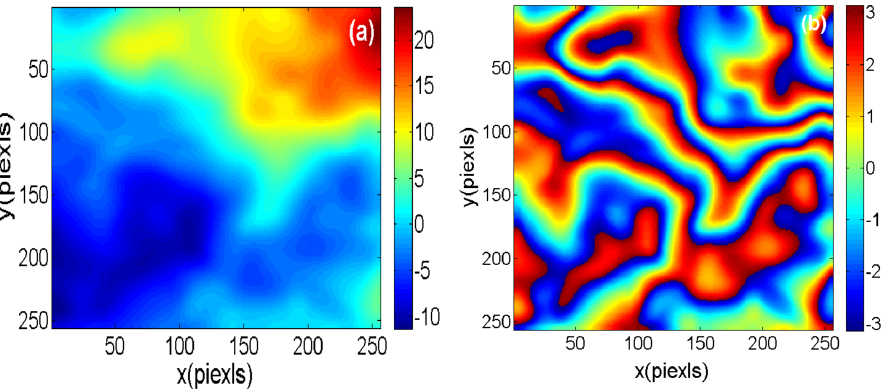
Figure 6. The ( a ) unwrapped and ( b ) rewrapped phase maps of Figure 2b. To validate the effectiveness of our method, the mean-squared error (MSE), which is defined by Equation (16), has been applied to describe the difference between the unwrapped and initial phase maps.